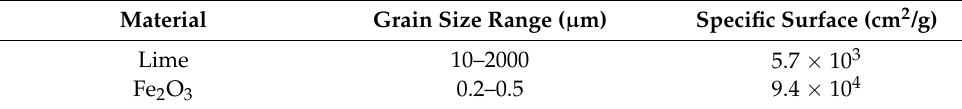
Table 1. Grain size and specific surface of lime mortar and iron (III) oxide powders.